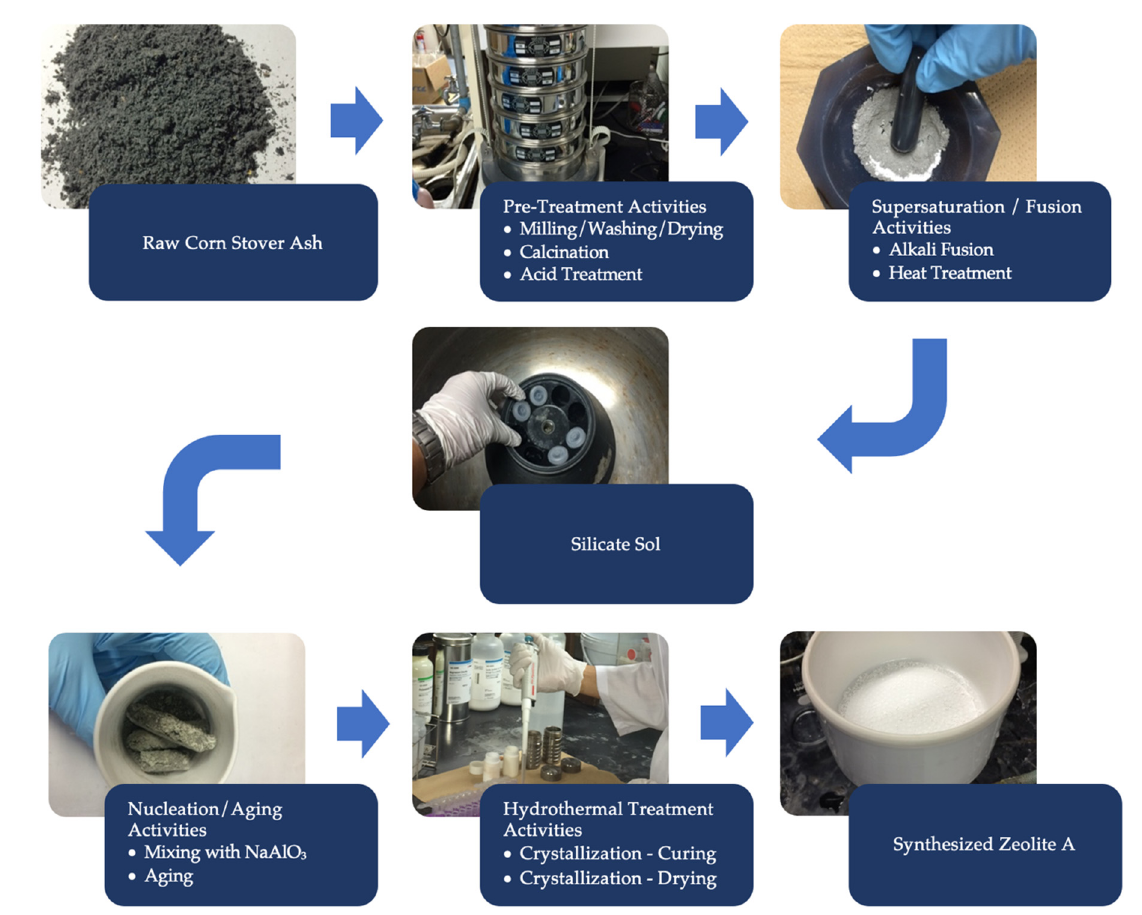
Figure 2. A schematic representation for the two-step zeolite A preparation method using corn stover ash.